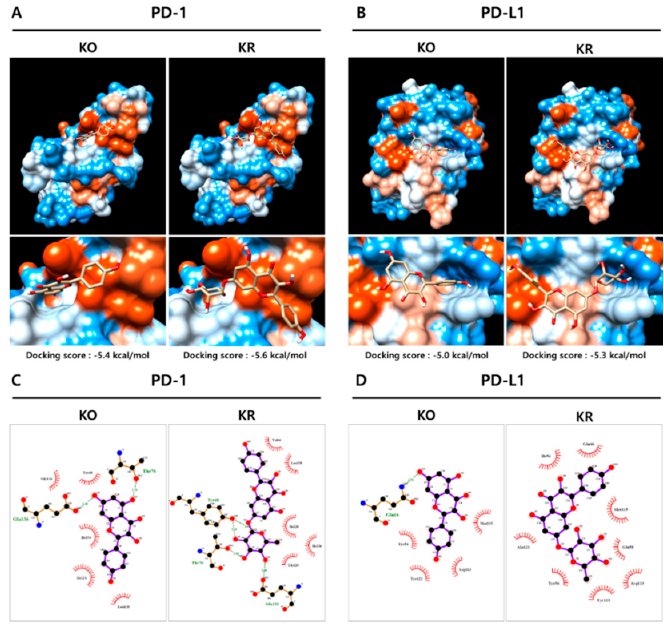
Figure 5. Hypothetical model of human PD-L1 or PD-1 in complex with KR. ( A , B ) Protein–ligand docking simulation for PD-1 ( A ) or PD-L1 ( B ) with each compound. Binding models were obtained through docking simulation derived from the PD-1/PD-L1 complex (PDB code 4ZQK) using AutoDock Vina. ( C , D ) Pharmacophore analysis of PD-1 ( C ) or PD-L1 ( D ). The hydrogen bonds and hydrophobic interactions between PD-L1/PD-1 and test inhibitors were analyzed using the LigPlot+ program.